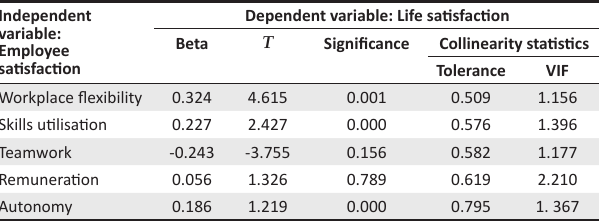
Dependent variable: Life